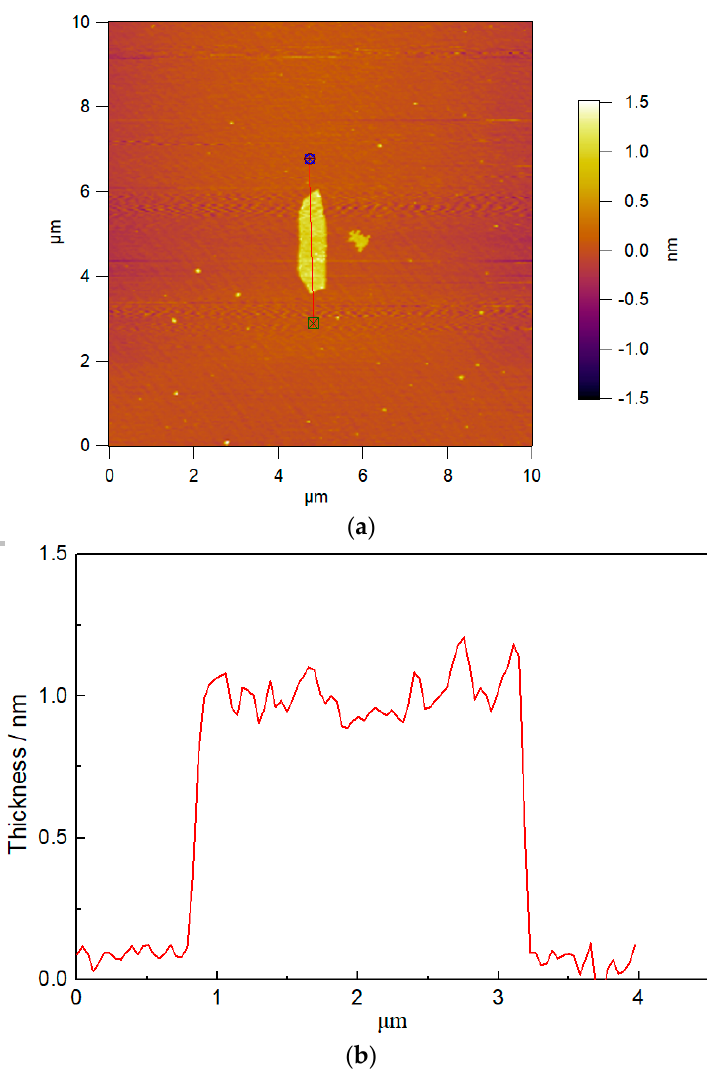
Figure 1. Atomic force microscope (AFM) image of the graphene oxide (GO) ( a ) The length and width of GO; ( b ) The thickness of GO.